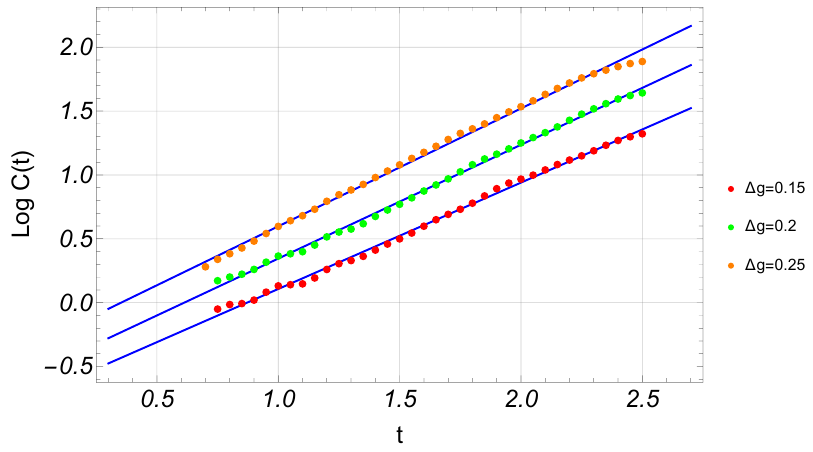
Figure 8: Plot of Log ( C ( t )) with time t for different quench amplitude ∆ g